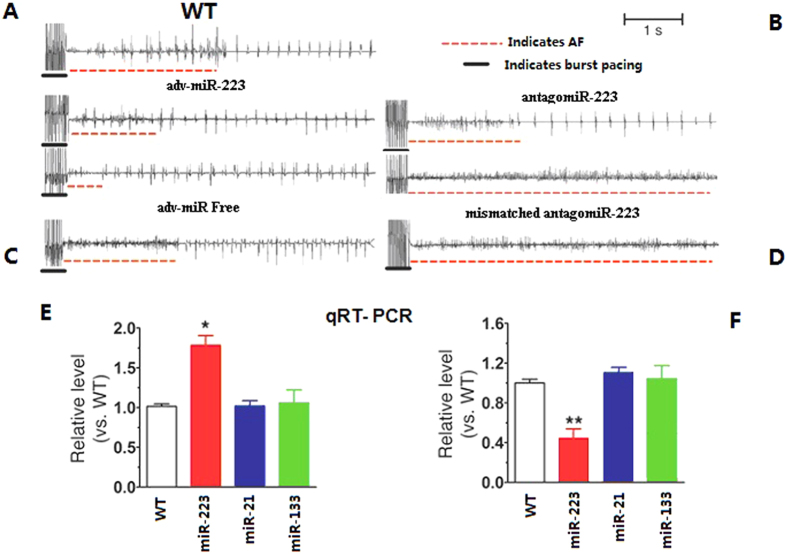
MiRNA-223 loss-of-function.(A) AF induction was substantially dampened in adv-miRNA-223-treated WT mice. (B) Surface electrocardiograms (ECG) detected changed spontaneous sustained AF in antagomiR-223-treated AMO/Tg mice. (C) Adv-miR-free, adenovirus vector without miRNA-223 (NC construct) knockdown in WT mice. (D) The above changes were not observed in WT mice treated with mismatched AMO/Tg mice. (E) Levels of miRNA-223 protein and mRNA were increased 2-fold in AF mice (*P < 0.05 vs. WT). (F) MiRNA-223 mRNA and protein expression were decreased in miRNA-223 knockdown mice (**P < 0.01).